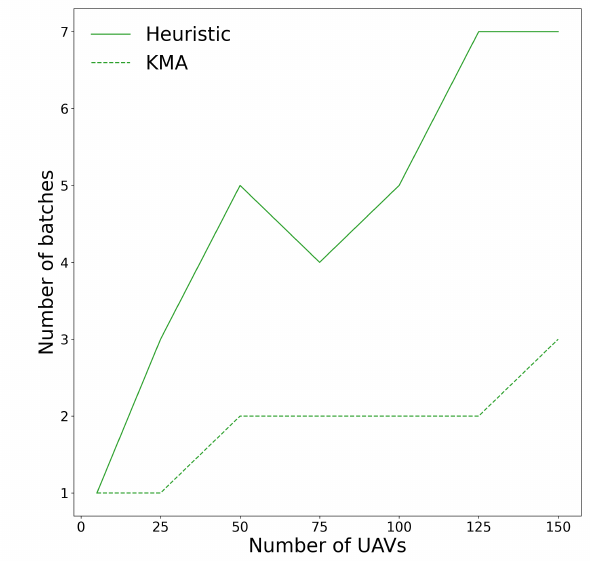
Figure 27. Number of batches between heuristic and KMA in the matrix